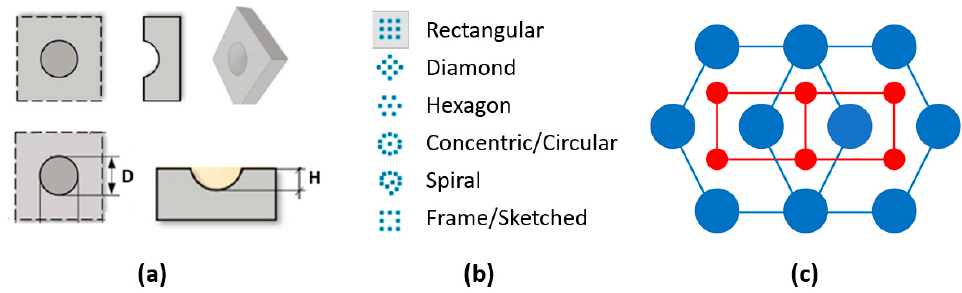
Figure 3. Cup-shaped micro-textures: ( a ) unit feature; ( b ) pattern; ( c ) hierarchy.